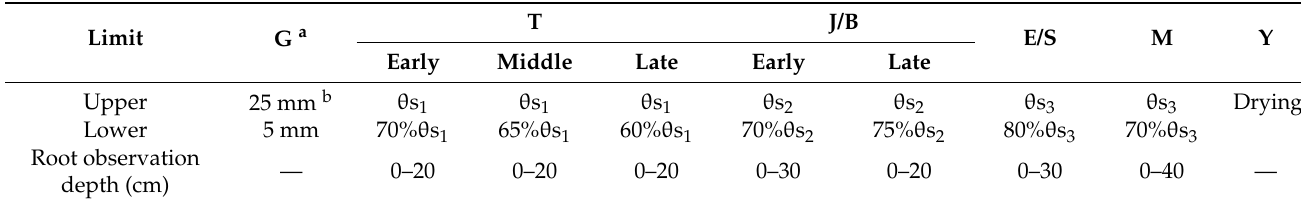
a G represents the regreening stage, T represents the tillering stage, J/B represents the jointing and booting stages, E/S represents the earing and sprouting stages, M represents the milk maturity stage, and Y represents the yellow maturity stage. b Data show the water depth thresholds during the regreening stage. θ s 1 , θ s 2 , θ s 3 represent the average saturated volumetric soil moisture for the 0–20, 0–30, and 0–40 layers, respectively.